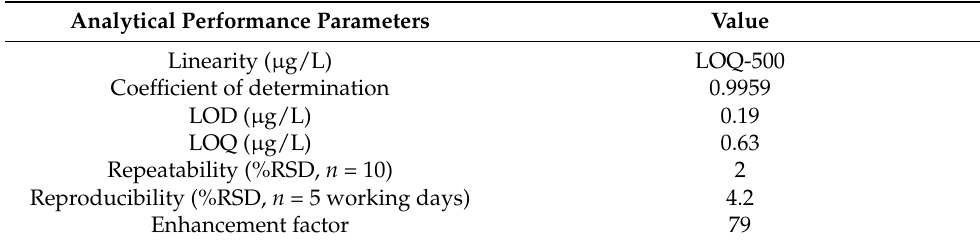
Table 8. Analytical figures of merit in ultrapure water.